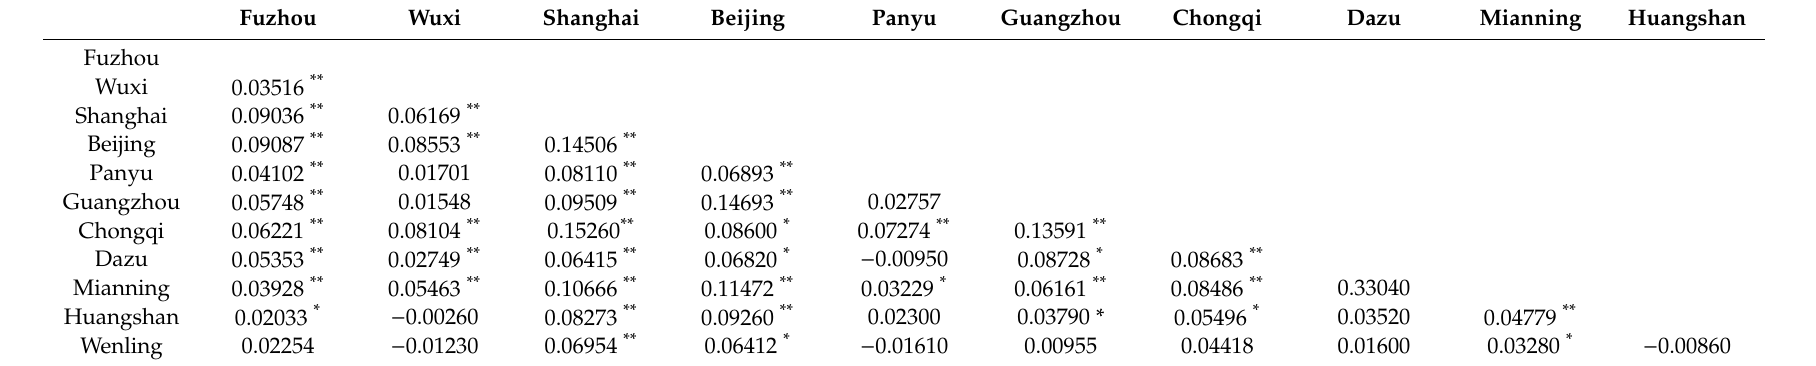
Table 6. Genetic di ff erentiation between pairs of red panda populations ( F ST ). * Significant ( p < 0.05); ** ( p <